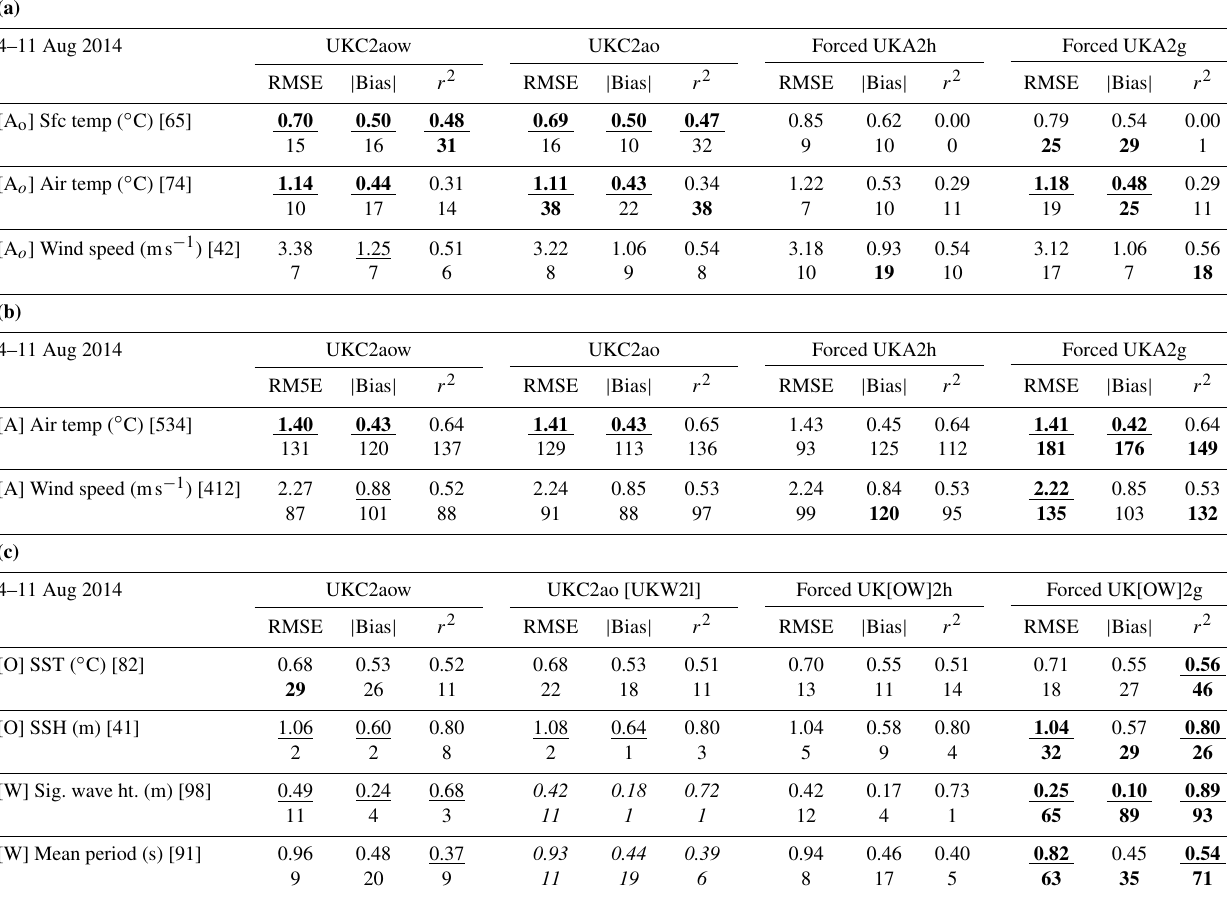
Table 4. Summary RMSE, bias and r 2 correlation coefficient statistics for the 7–11 August 2014 case study. Average statistics are computed from a comparison of model output against in situ observations of (a) atmosphere (A o ) model variables over sea grid cells only (b) all atmosphere [A] model variables, and (c) ocean [O] and wave [W] model variables. The relevant forced configuration with high-resolution forcing UKW2h, UKO2h and UKA2h are treated as the reference control model. Results showing a statistically significant difference from the reference according to a t test at the 95% confidence level are underlined. Those also showing an improvement against the reference are also in bold. Also listed for each variable under the horizontal lines for each metric is the number of sites for which the model configuration provided the best statistic relative to the other model configurations tested for this case. The configuration with the highest number of sites listed is highlighted in bold. Numbers in square brackets show the number of observation locations assessed for each